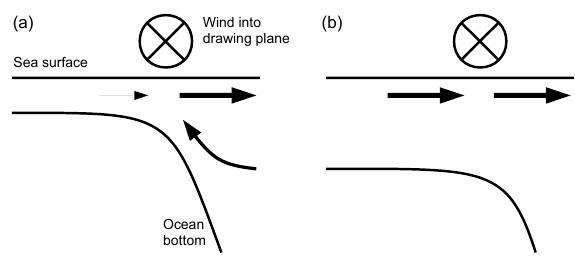
Figure 3. Schematic of the mechanism behind wind-driven shelf break upwelling. When wind blows along the shelf break, it gener- ates an Ekman current (horizontal arrows) off-shelf. (a) When the shelf is shallow enough, the current over the shelf is slowed down, leading to a horizontal divergence and thus pressure gradient that is filled by drawing up deeper waters. (b) When the shelf is deeper, there is no horizontal divergence. Other mechanisms, such as dy- namic uplift, are independent from wind and not discussed here, but see e.g. the book by Kämpf and Chapman